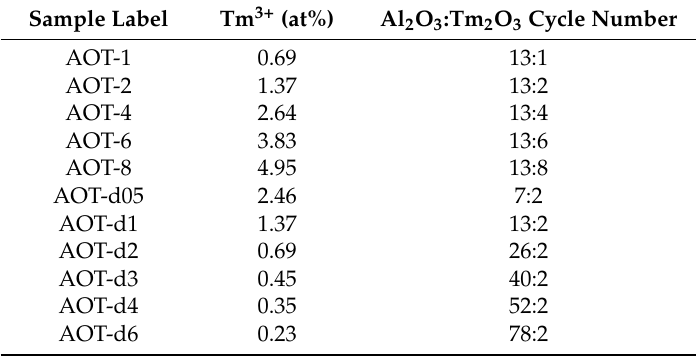
Table 1. The corresponding experimental parameters for